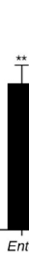
Figure 1. Nitrogen fixation ability of the selected diazotrophic bacterial strains. 15 N 2 incorporation was used to assess the N 2 fixation capacity of BPMP-PU-28 (Pseu: Pseudomonas urmiensis ) and BPMP-EL-40 (Enter: Enterobacter ludwigii ) strains. E. coli (5-alpha F’Iq E. coli , New England Biolabs) was used as the negative control. The gas phase (6 mL) above the bacterial suspension (3 mL) contained about 16% 15 N 2 , 65% 14 N 2 and 18% O 2 . Cells were centrifuged after 5 days of incubation (at 37 °C and 200 rpm), and the δ 15 N 2 in the bacterial pellets was determined. Means ± SE (n = 3). ** and *** above the bars indicate that the difference with the negative control ( E. coli ; #), is statistically significant (Student’s t -Test, p ≤ 0.01 and 0.001, respectively).